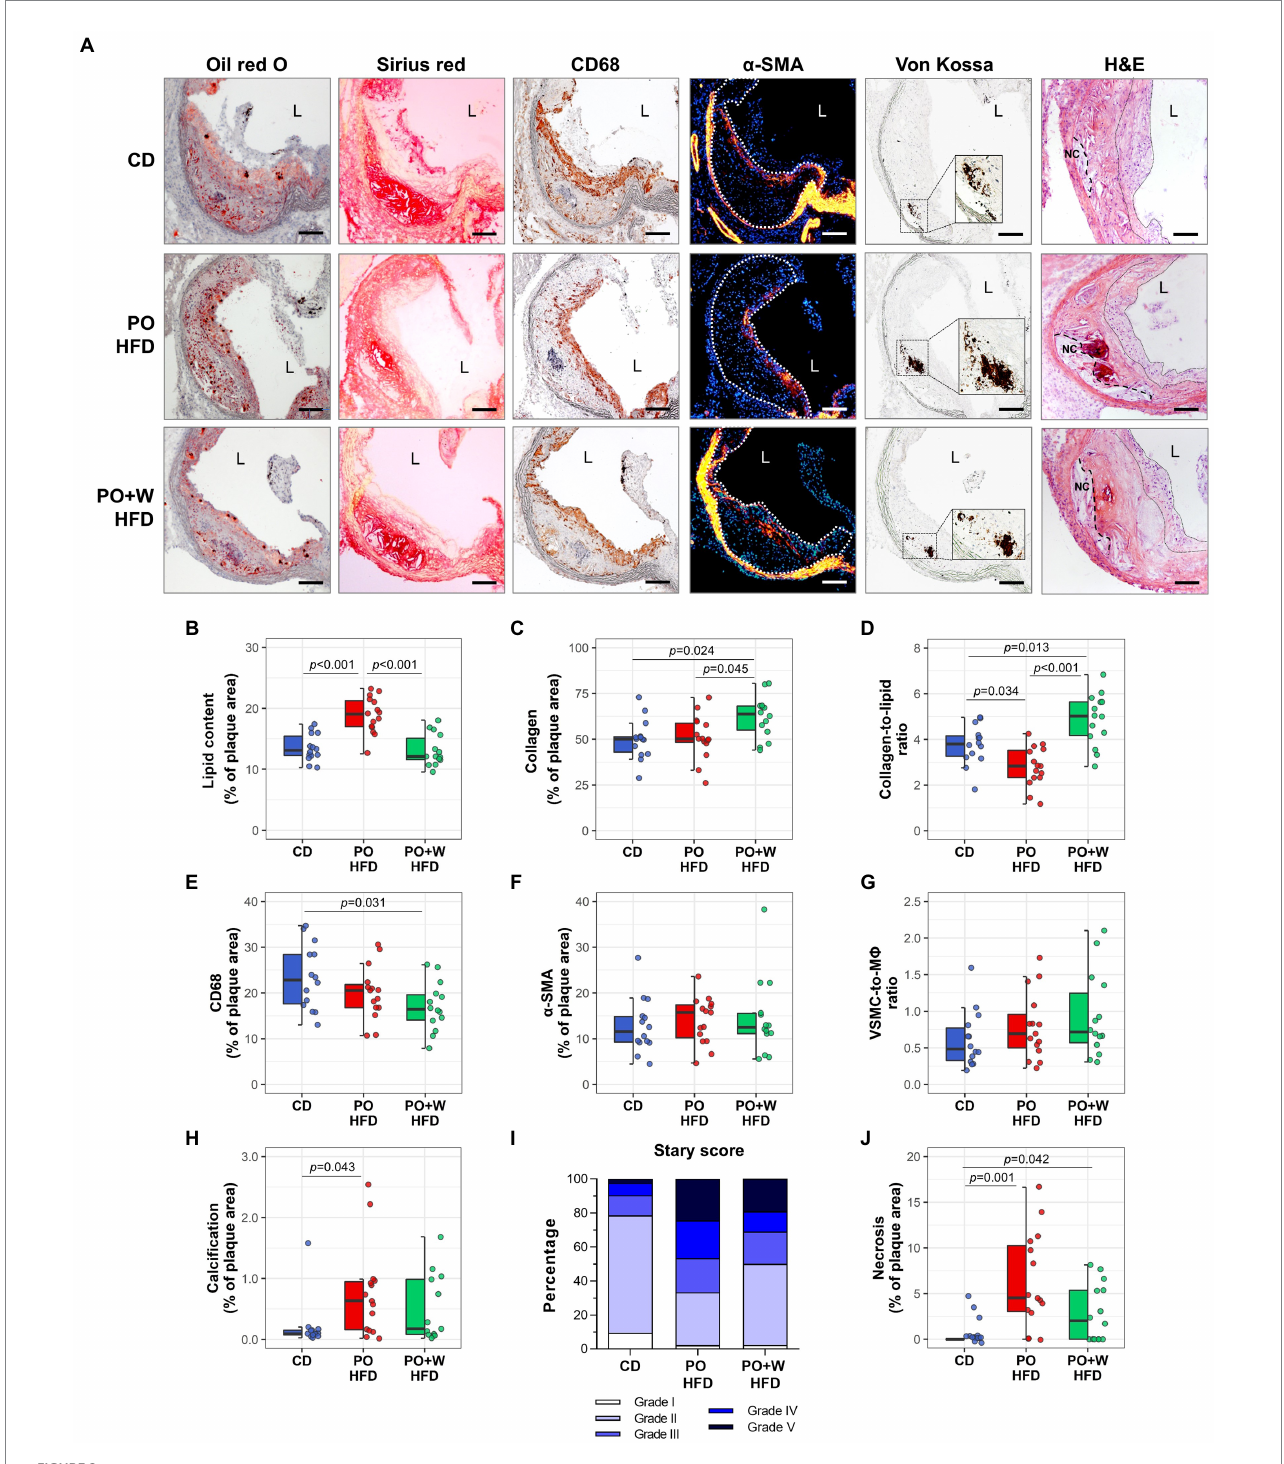
FIGURE 2 Inclusion of walnuts contributes to prevent phenotypes predicting plaque instability and progression induced by high-fat diet. (A) Representative images of Oil red O/hematoxylin, Sirius red, CD68, α -SMA, Von Kossa, and hematoxylin–eosin (H&E)-stained sections from each group of intervention [magnification × 100; scale bars, 100 μ m; high-magnification fields (squared areas)]. (B–H) Quantification of parameters used to rate plaque stability, including intraplaque lipid (Oil red O, B ), collagen (Sirius red, C ), collagen-to-lipid ratio (D) , macrophages (CD68, E ), VSMC ( α -SMA, F ), VSMC-to- macrophage (M Φ ) ratio (G) , and calcification (Von Kossa, H ). (I) Classification of aortic lesions according to the Stary method (grades I–V). (J) Measurement of intraplaque necrotic area in Sirius red-stained histological sections. Dot and box plots show individual values and depict the median (horizontal bar), interquartile range (IQR, hinges) and 1.5 × IQR (whiskers). CD, control diet ( n = 14); PO HFD, palm oil-based high-fat diet ( n = 15); PO + W HFD, palm oil + walnuts high-fat diet (isocaloric inclusion of 3% of walnuts at expense of palm oil, n = 14). p values obtained by one-way ANOVA (after log- transformation) with Bonferroni post hoc correction. Dashed lines in α -SMA images define atherosclerotic lesions. Dashed and dotted lines in H&E images delimit necrotic cores (NC) and fibrous cap regions, respectively. L,